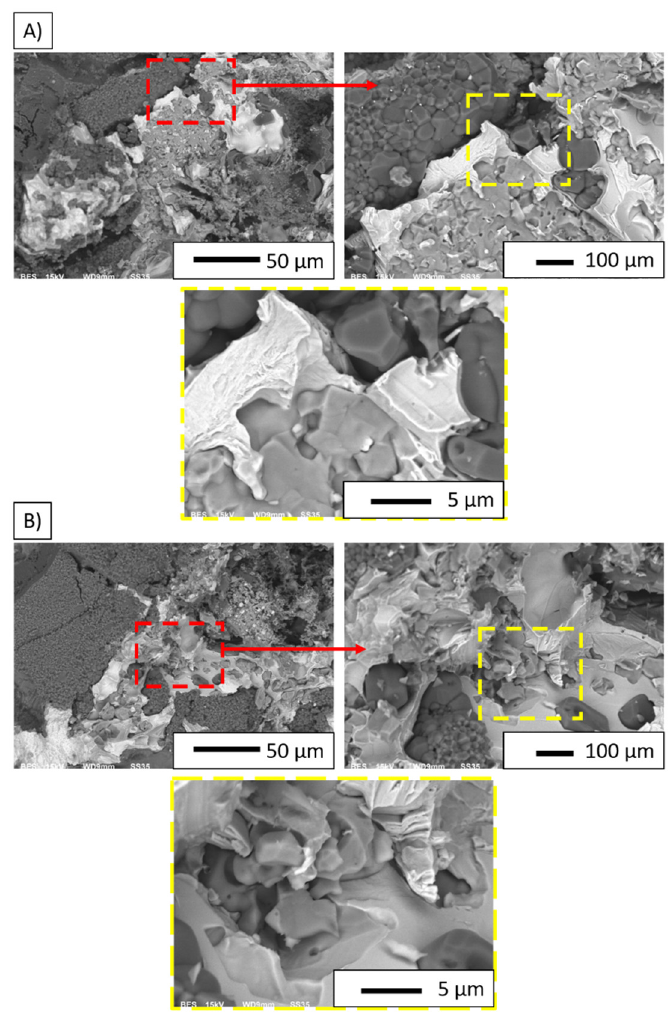
Figure 11. SEM images of fractographic observation of samples: ( A ) Series I; ( B ) Series II. EDS analysis results in the form of the element distribution maps shown in Figure 12A,A’,B,B’ confirmed the chemical composition of the light and dark areas in the SEM images as metals, solid solution, and Al 2 O 3 , respectively. The distribution of the elements on the fracture surface revealed a solid solution of nickel and titanium in both studied samples. This was confirmed by the EDS analysis of the characteristic areas visible in Fig- ure 12. The results of the chemical composition analysis are presented in Table 4. Images A and B correspond to the areas with separated particles of Ni and Ti while A’ and B’ images reflect areas composed of both elements, titanium and nickel, which are in the solid solution state. EDS measurements did not allow us to identify whether the analysed area is an intermetallic or solid state. Therefore, previously presented XRD measurements were applied (Figure 9). Uniformly distributed areas of pure titanium and nickel were also observed.